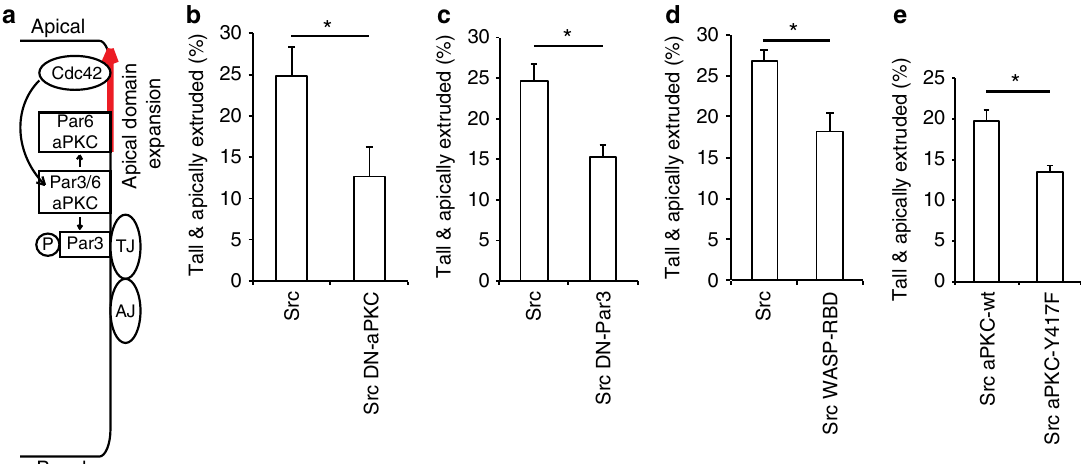
Fig. 8 vSrc modulates apical polarity complex to facilitate extrusion. a A schematic model of regulation of apicobasal polarity by Cdc42 (adapted from ref. 49 ). The Par3-Par6-aPKC complex is recruited to the cell surface in a Par3-dependent manner 46 , and is regulated by apically localised Cdc42. Active Cdc42 stimulates phosphorylation, dissociation and relocation of Par3 to the apical-lateral border at tight junctions (TJ), while Par6-aPKC moves apically to de fi ne the apical domain 46,47,49 . b The effect of dominant negative aPKC on vSrc-driven extrusion. Embryos were injected with the following constructs: dUAS:EGFP-vSrc and dUAS:EGFP-vSrc;DN-aPKC. Data are mean ± s.d. of three independent experiments (total number of embryos: n Src = 31; n Src,DN-aPKC = 31). * P < 0.05 (Student ’ s t -test). c The effect of dominant negative Par3 on vSrc-driven extrusion. Embryos were injected with the following constructs: dUAS:EGFP-vSrc and dUAS:EGFP-vSrc;DN-Par3. Data are mean ± s.d. of three independent experiments (total number of embryos: n Src = 36; n Src,DN-Par3 = 34). * P < 0.01 (Student ’ s t -test). d The effect of overexpression of WASP-RBD-GFP on vSrc-driven extrusion. Embryos were injected with the following constructs: dUAS:EGFP-vSrc and dUAS:EGFP-vSrc;WASP-RBD-GFP. Data are mean ± s.d. of three independent experiments (total number of embryos: n Src = 31; n = 36). * P < 0.01 (Student ’ s t -test). e The effect of phosphomimetic aPKC-Y417F on vSrc-driven extrusion. Embryos were injected Src,WASP-RBD-GFP with the following constructs: dUAS:EGFP-vSrc;aPKC-wt or dUAS:EGFP-vSrc;aPKC-Y417F. Data are mean ± s.d. of three independent experiments